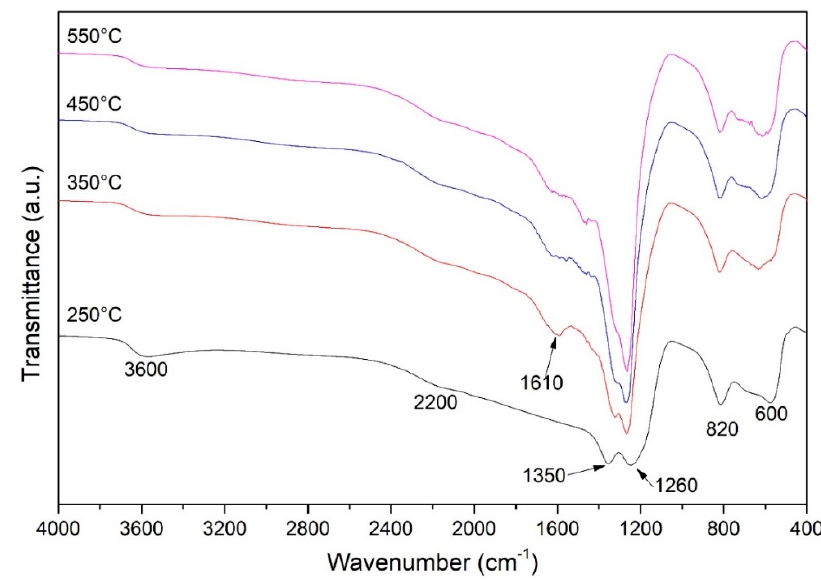
Figure 2. Fouriertransforminfrared(FT-IR)spectraofZrO 2 Figure 2. Fourier transform infrared (FT-IR) spectra of ZrO 2 samples after annealing at different temperatures.